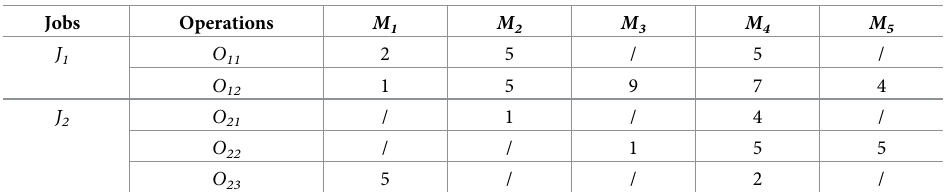
Table 3. Example of FJSP.